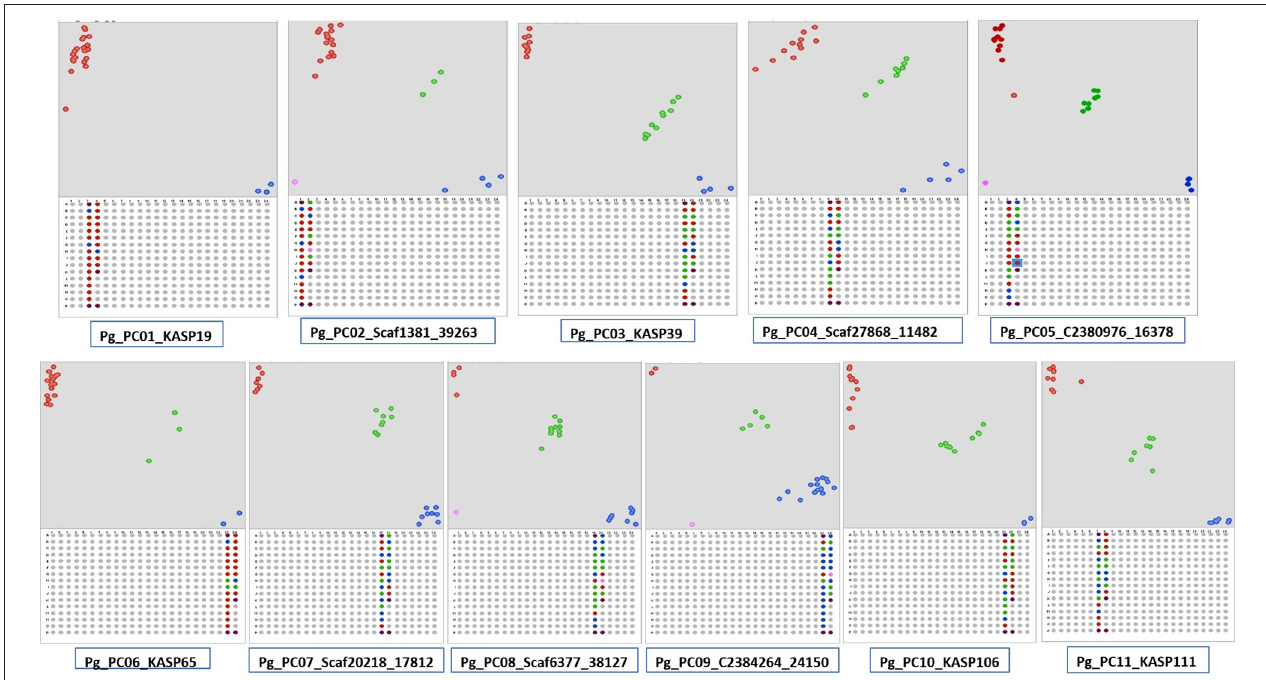
FIGURE 5 | Kompetitive allele-specific polymorphism (KASP) detection assay development in guava. Single nucleotide polymorphisms (SNPs) were identified in AS/PL/L-49/AC/PP by Freebayes followed by Polymarker. Scatter plots for the selected KASP assay show clustering of genotypes on the X- (FAM) and Y- (HEX) axes on the 11 pseudochromosomes. Genotypes exhibiting blue color have a FAM-type allele, red-colored have a HEX-type allele, and green-colored have both types of alleles